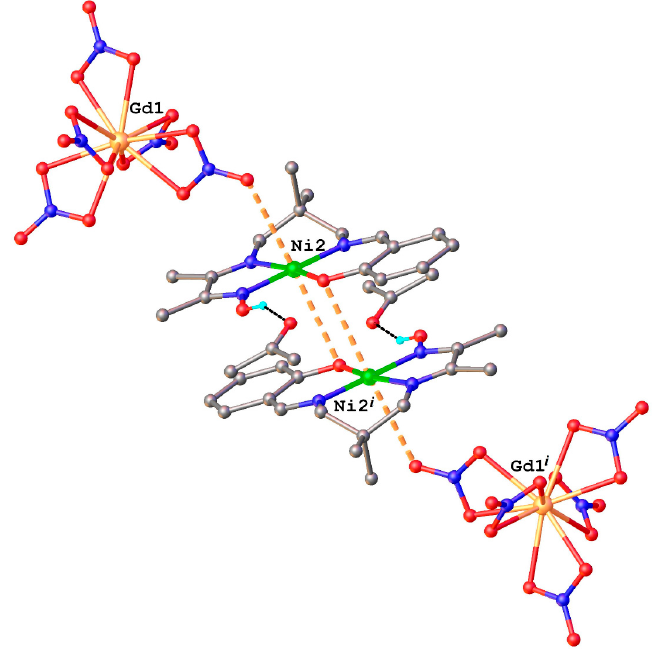
Figure 7. View of the {NiL 5 } 2 dinuclear entity, showing the Ni2 coordination geometry. Symmetry code: ( i ) 1 − x , 1 − y , 1 − z .